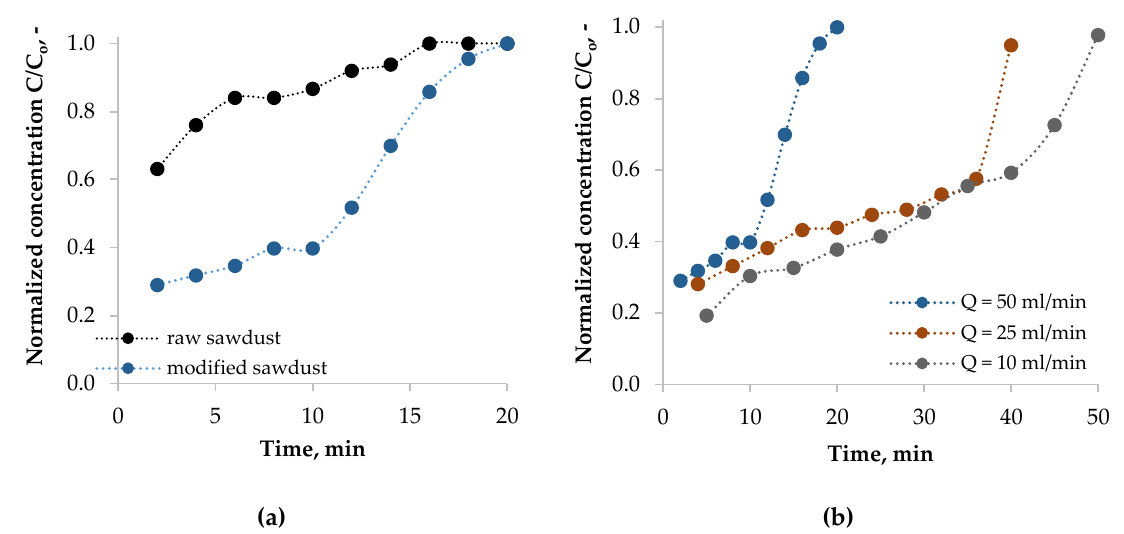
Figure 6. ( a ) Comparison of sorption performance of raw and modified sawdust at a flow rate of 50 mL/min; ( b ) effect of flow rates on the adsorbed quantity of BTX onto a modified sawdust fixed-bed column.